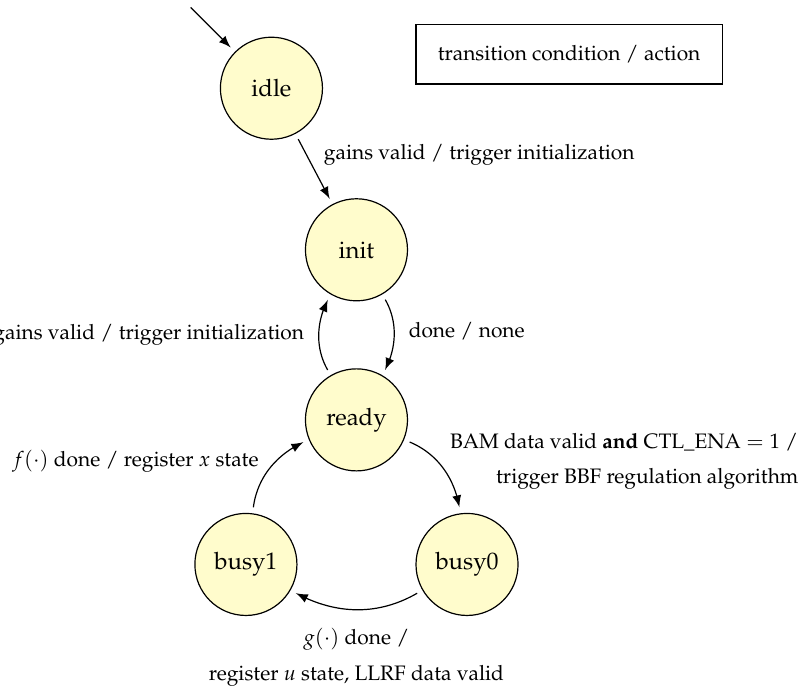
Figure 14. State diagram showing the operation of the regulator